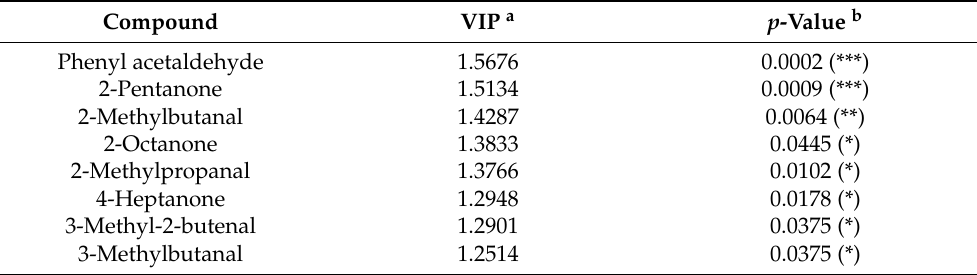
Table 7. OPLS-DA results showing the critical volatile carbonyl compounds (variable importance in projection VIP > 1.0, p < 0.05) present across semisweet Huangjiu samples of different regions (Zhejiang, Jiangsu, Shanghai, Fujian). Compound VIP a p -Value b Phenyl acetaldehyde 1.5676 0.0002 (***) 2-Pentanone 1.5134 0.0009 (***) 2-Methylbutanal